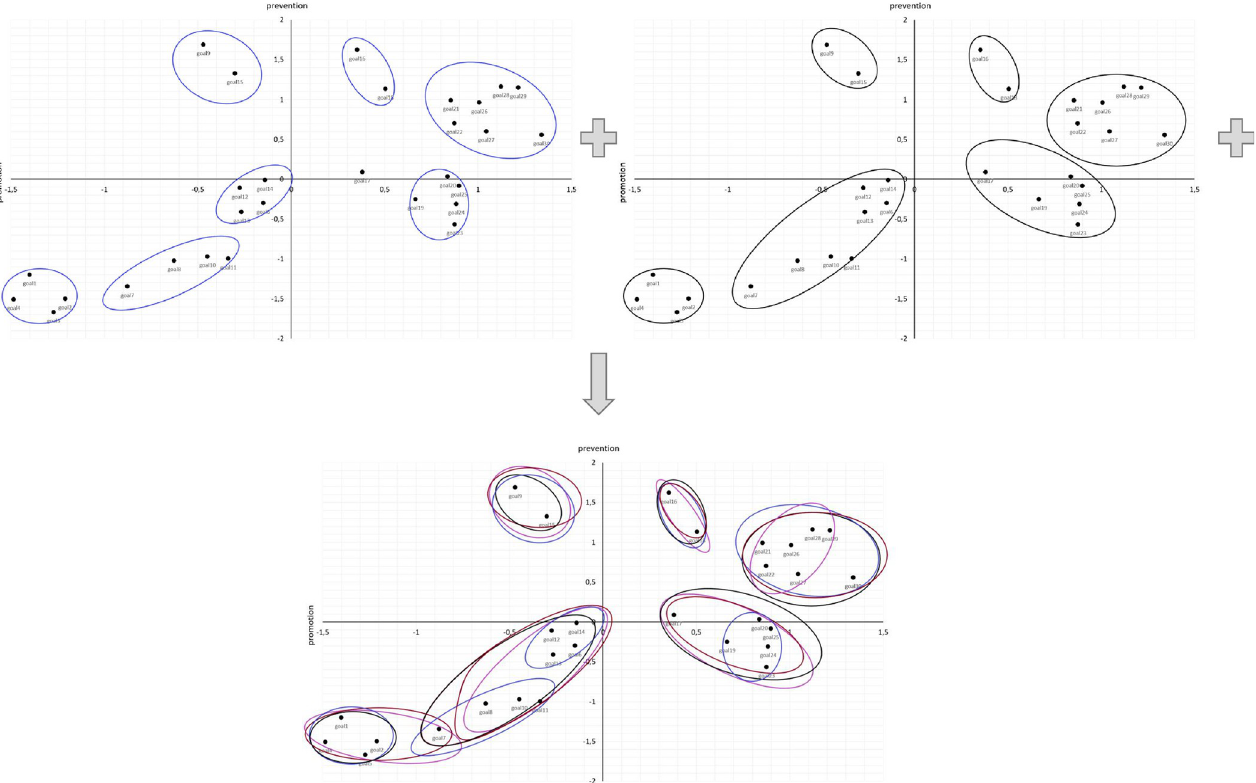
Fig 2. An example of possible cluster solutions in Study